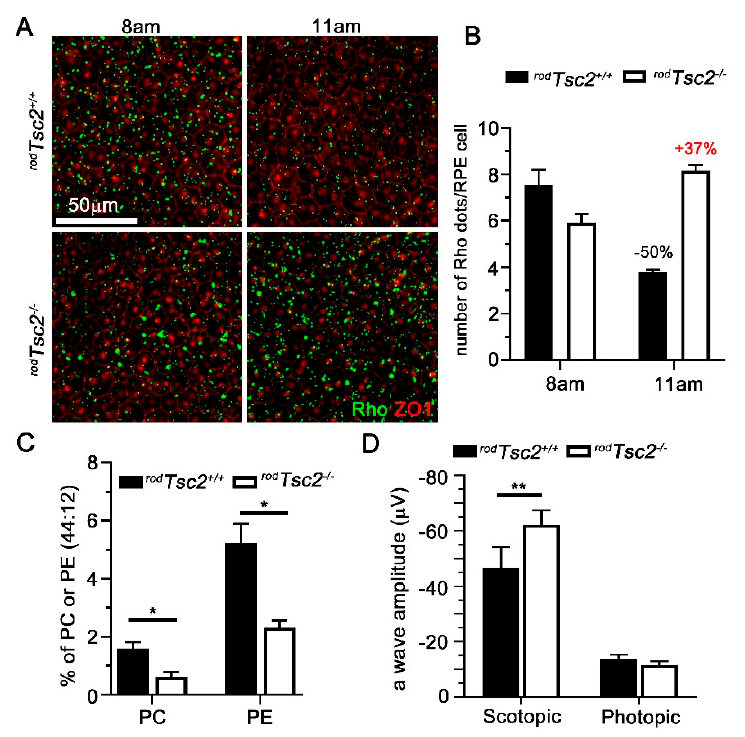
Figure 3. RPE phagocytic activity is delayed in 2 M old rod Tsc2 − / − mice. ( A ) Representative images used for quantification in ( B ) of RPE flat mounts at 8am and 11am, showing accumulation of shed POS in both rod Tsc2 +/+ and rod Tsc2 − / − mice at 2 M (green: Rhodopsin; red: ZO-1, Zona Occludens 1 protein marking tight junctions of RPE cell boundary; scale bar = 50 µm). ( B ) Quantification of number of POS (Rhodispins: RHO+ dots) accumulated on RPE flat mounts at 8am and 11am in 2 M old mice. Bar shows average number of POS (Rho) per RPE cell ± S.E.M. ( n = 6 RPE flat mounts). ( C ) Percentage of di-DHA (44:12) PC and PE phospholipids in total retinal extracts from both rod Tsc2 +/+ (black bar) and rod Tsc2 − / − (white bar) mice ± S.E.M. ( n = 3 mice, * p < 0.05). ( D ) Average of scotopic and photopic ERG recordings from both rod Tsc2 +/+ (black bar) and rod Tsc2 − / − (white bar) mice at 2 M of age. Bars show average a-wave amplitude (µV) ±S.E.M. ( n = 8 and 14 mice, respectively; ** p < 0.01). Scotopic recordings were performed at 0.1 cd.s/m 2 . Photopic ERG recordings used a background intensity of 9 cd.s/m 2 and a flash intensity of 10 cd.s/m 2